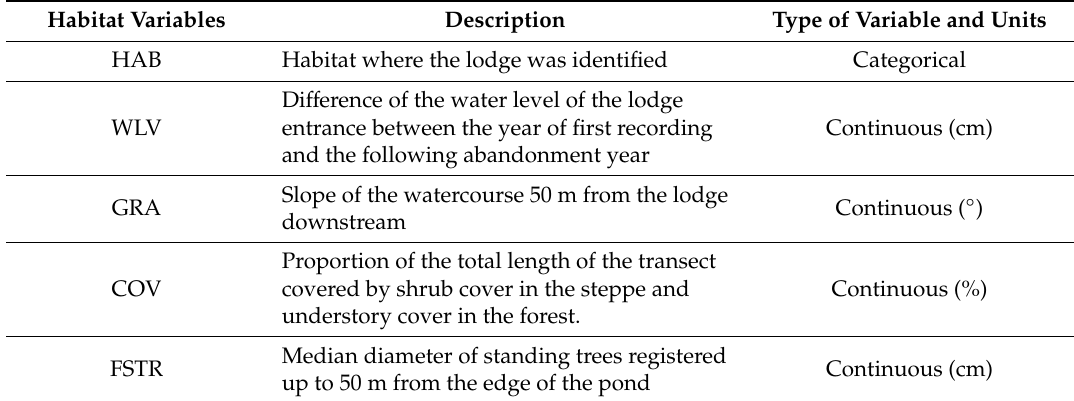
Table 1. Description of the variables used in the models to predict the probability of abandonment.